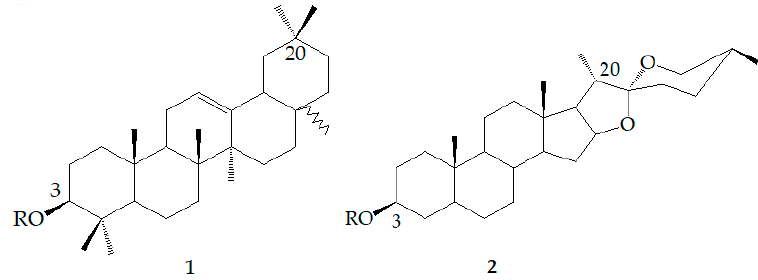
Figure 1. Chemical structures of triterpenoid saponin ( 1 ) and steroidal saponins ( 2 ). R = sugar moiety.